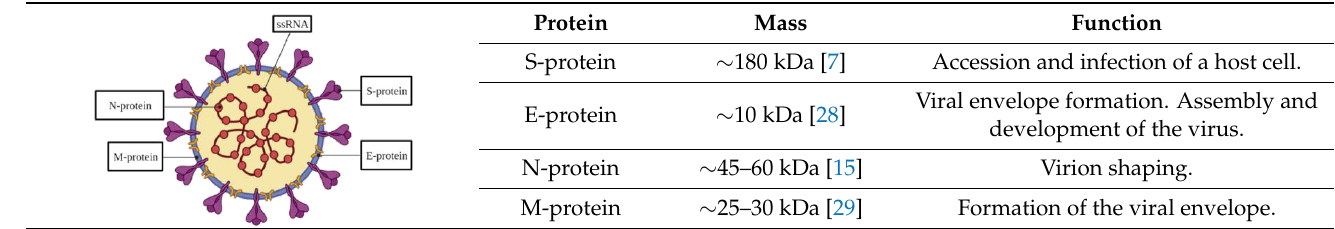
Table 1. Location, mass, and function of SARS-CoV-2 structural proteins.